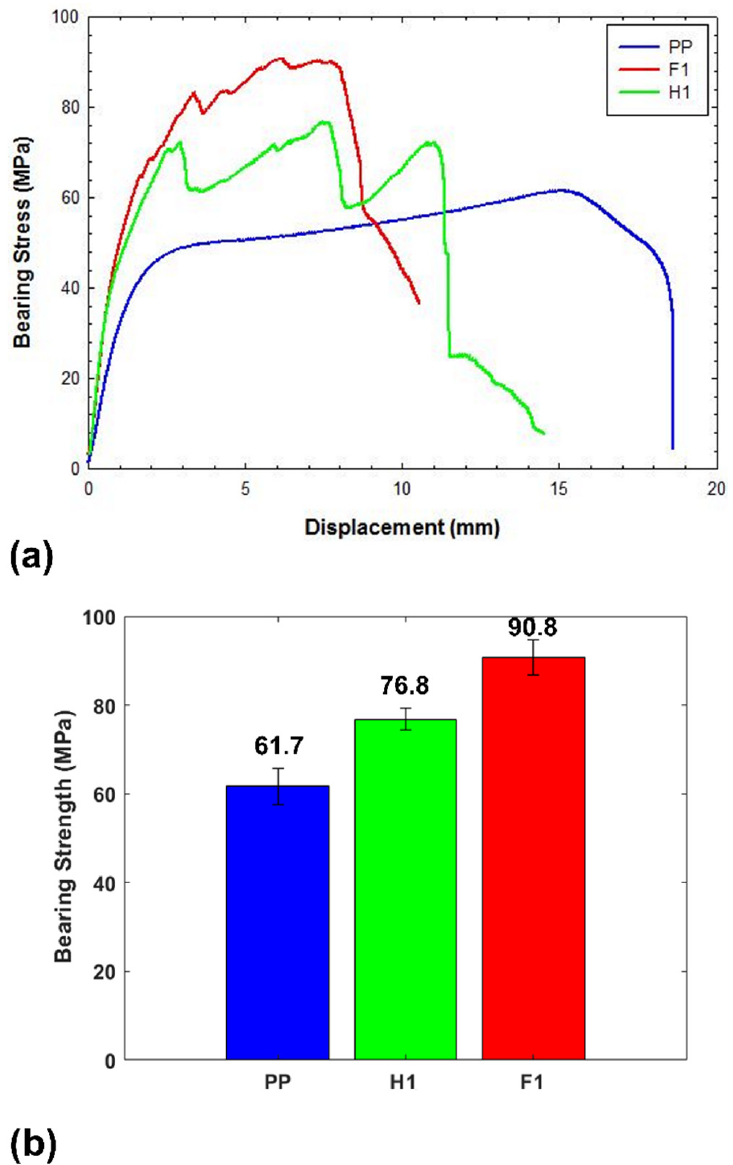
Figure 7. ( a ) Typical bearing stress-displacement curves and ( b ) bearing stress strength for specimens with W/D = 6.